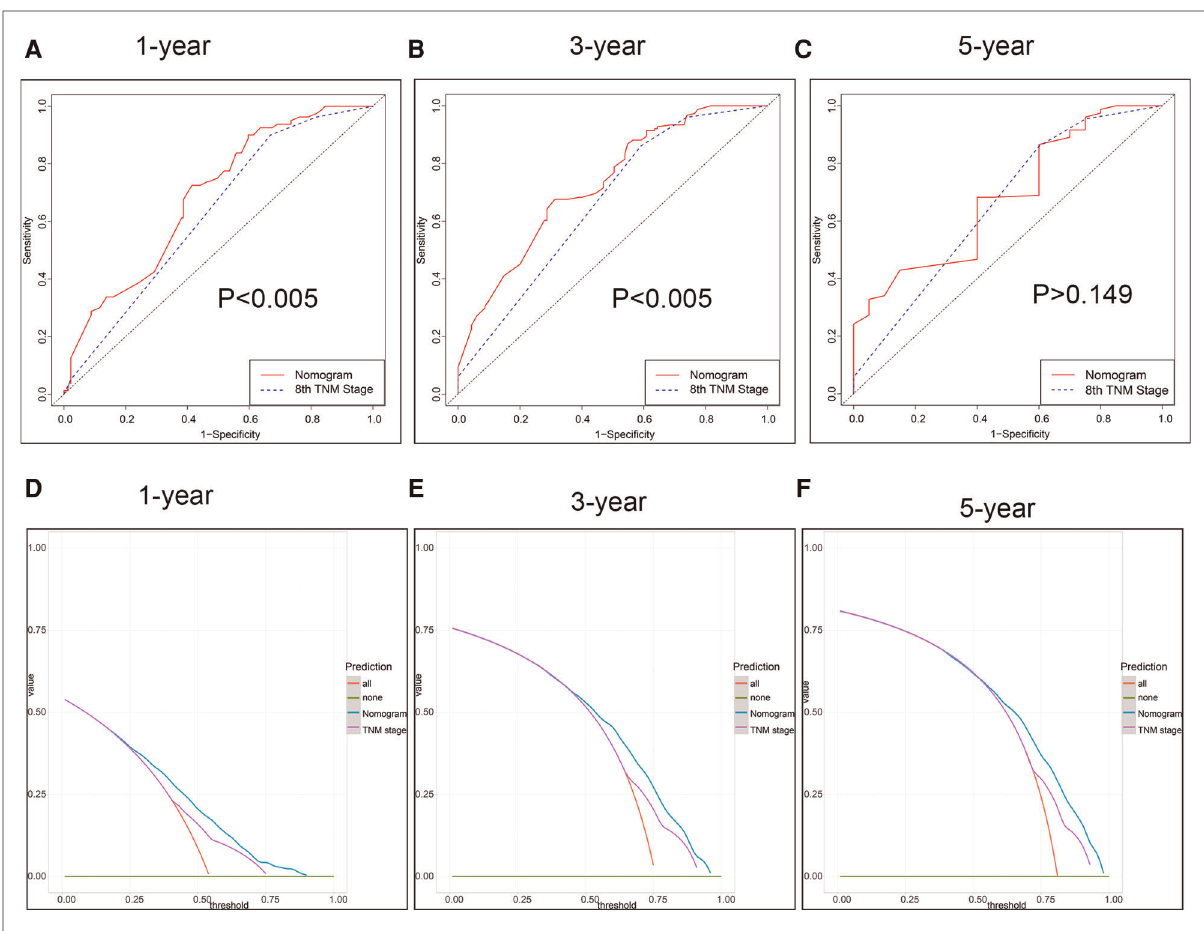
FIGURE 8 The ROC curve and DCA of the model from our centre. ( A – C ) ROC curve for 1-, 3- and 5-year. ( D – F ) DCA for 1-, 3- and 5-year